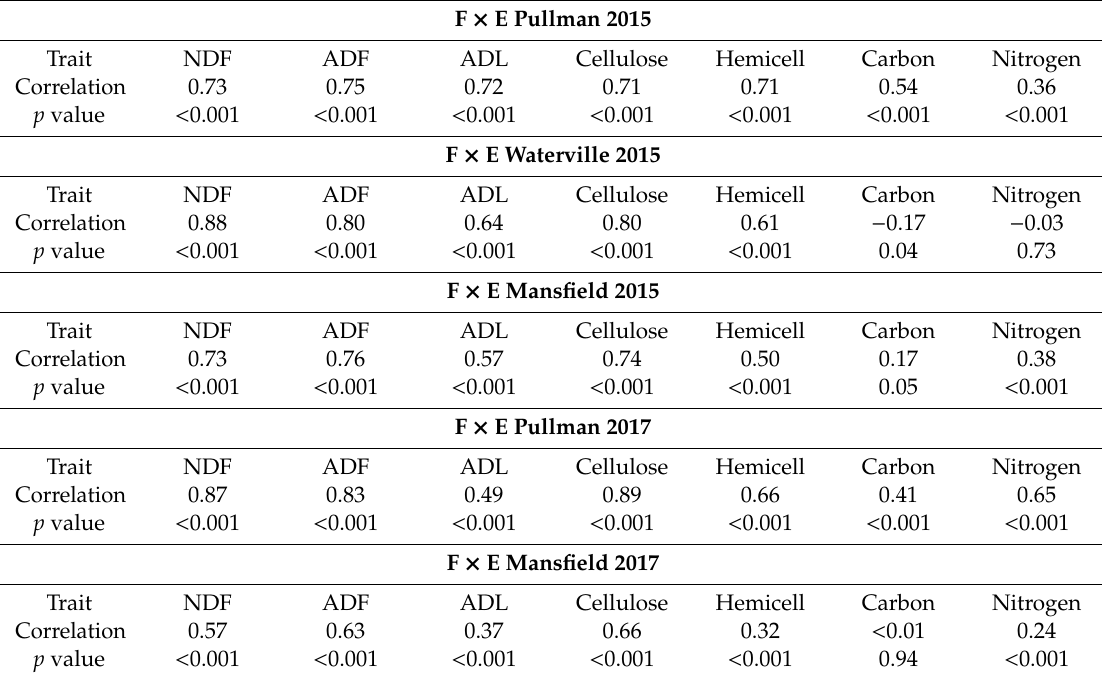
Table 5. NIRS Coe ffi cients of Pearson Correlation (and P values) of laboratory reference data and NIRS predicted values for NDF, ADF, ADL, cellulose, hemicellulose, C, and N in five environments from the Finch × Eltan breeding